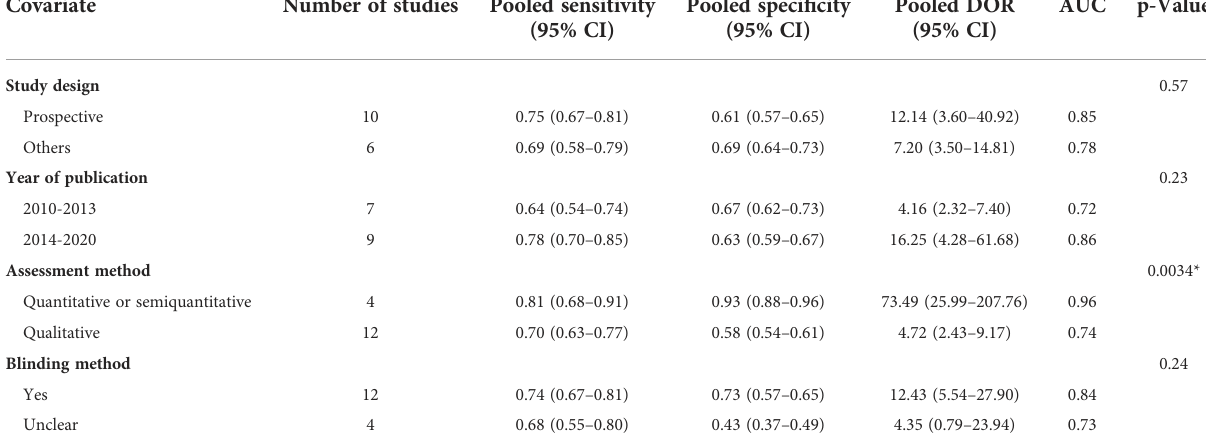
TABLE 3 Meta-regression and subgroup